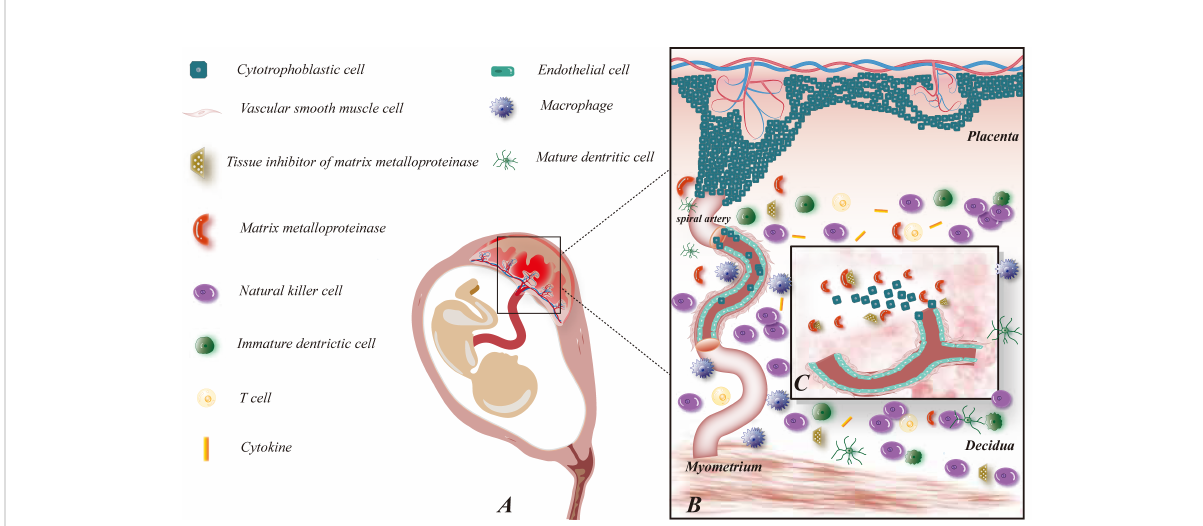
FIGURE 1 Maternal-fetal interface immune microenvironment on early pregnancy and role of MMP on embryo implantation. (A) This fi gure demonstrates the relative location of the fetus and its appendages on the maternal uterus; (B) This fi gure shows the composition of the maternal-fetal interface immune microenvironment, including fetal-originated cytotrophoblast cell, immune cell subsets: NK cells, macrophages, T cells, DC cells, cytokines, etc., maternal uterine spiral artery: vascular smooth muscle cells and vascular endothelial cells, MMP and TIMP families; (C) This fi gure illustrates the enlarged view of the functions of MMP on early pregnancy. MMP and TIMP assist the process of trophoblast invasion and uterine spiral artery remodeling by degrading